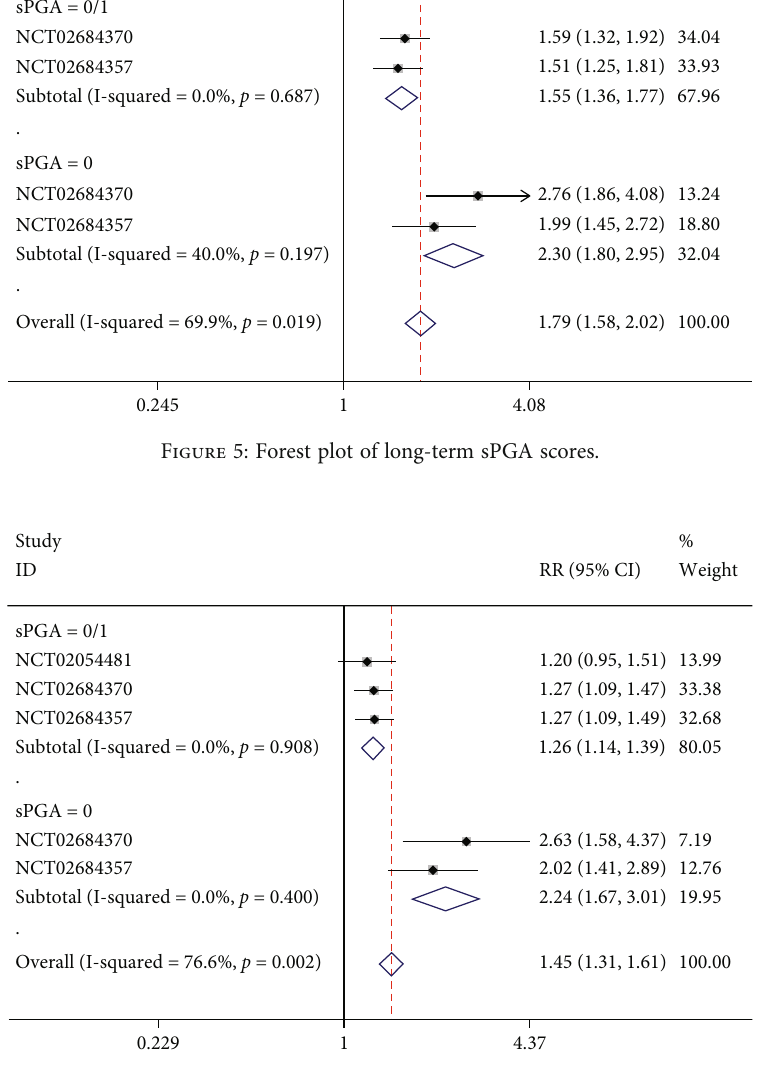
Figure 6: Forest plot of short-term sPGA